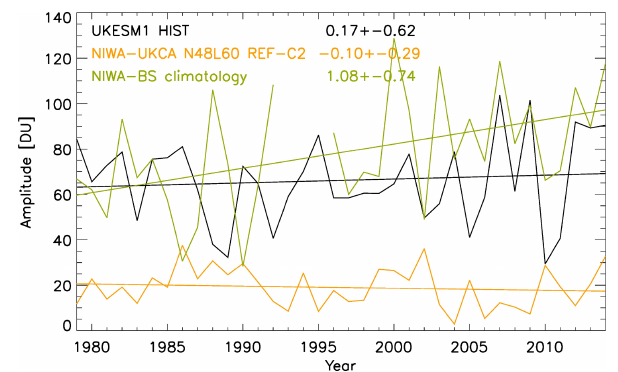
Figure 26. Same as Fig. 25 but for the phase b , in